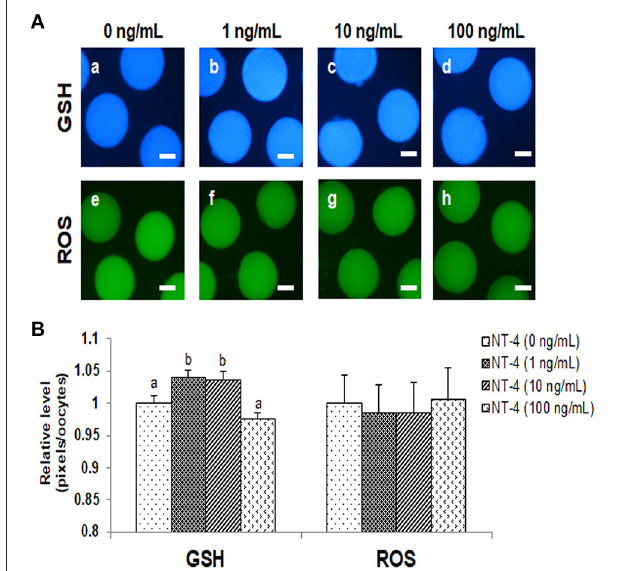
FIGURE 3 | Epifluorescent photomicrographic images of in vitro matured porcine oocytes. (A) Oocytes were stained with CellTracker Blue (a–d) and 2 ′ , 7 ′ -dichlorodihydro-fluorescein diacetate (H 2 DCFDA) (e–h) to detect intracellular levels of glutathione (GSH) and reactive oxygen species (ROS), respectively. (B) Effect of NT-4 in maturation medium on intracellular GSH and ROS levels in in vitro matured porcine oocytes. Bars with different letters (a, b) represent significantly different values ( p < 0.05). Number of GSH samples = 80, Number of ROS samples = 80. The experiment was performed four times. Scale bars = 50 µ